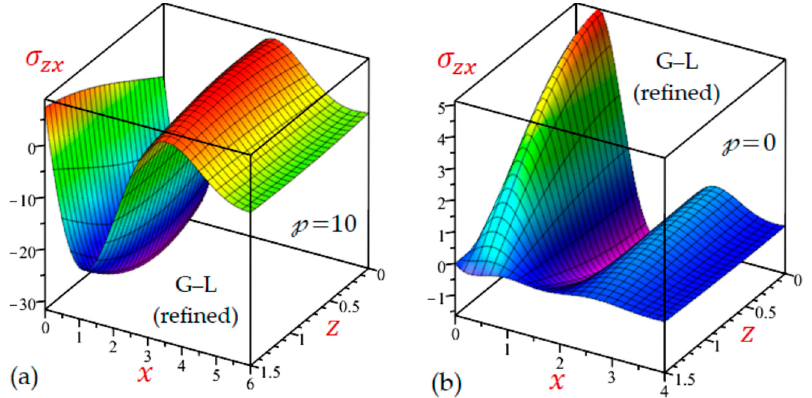
Figure 27. 3D distributions of the transverse shear stress σ zx of the rotating half-space: ( a ) with initial